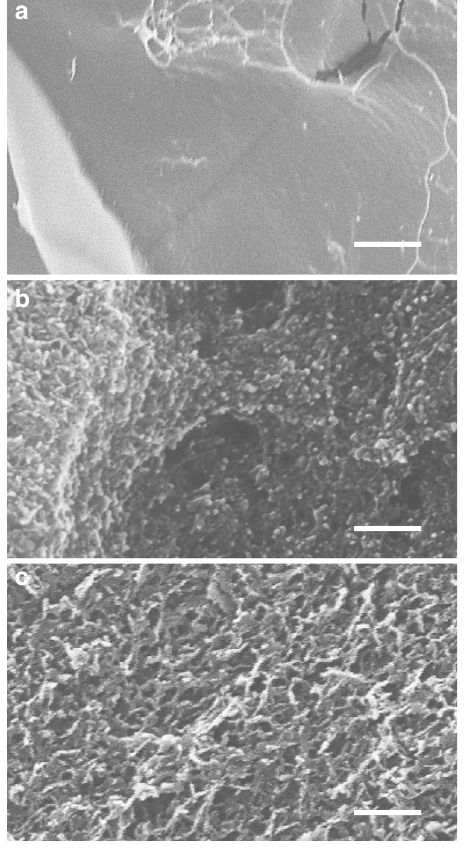
Fig. 3 Scanning electron microscope characterization of chemical and physical gels. HABP chemical gels ( a ) compared with HA-(BP) 3 • Laponite physical gels ( b ) and chemical gels assembled through mixing of pyridyldithio-modi fi ed hyaluronan (HA-SSPy) with thiol-functionalized Laponite (Laponite • BP-SH) ( c ). Scale bar = 200